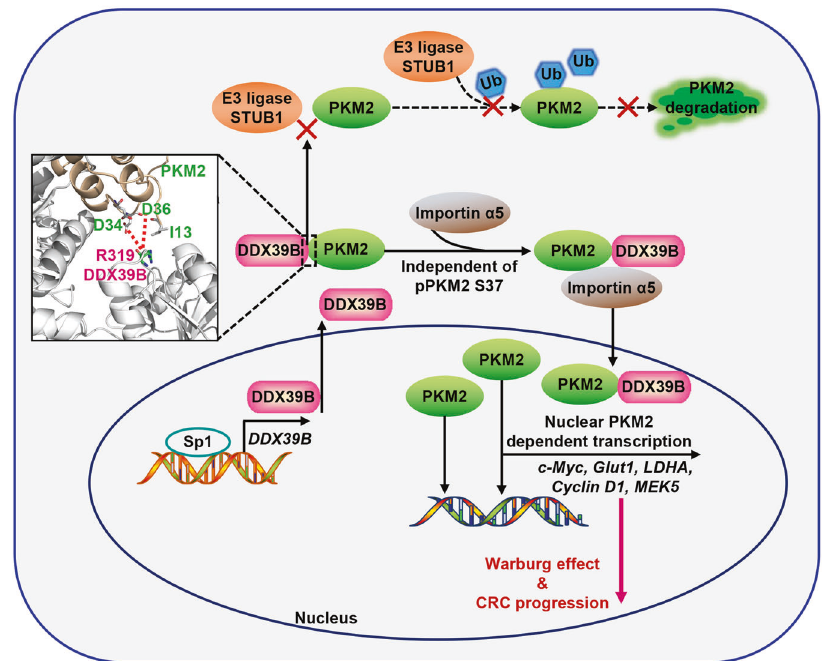
Fig. 9 Schematic diagram of the Sp1/DDX39B/PKM2 axis in regulation of the Warburg effect and CRC